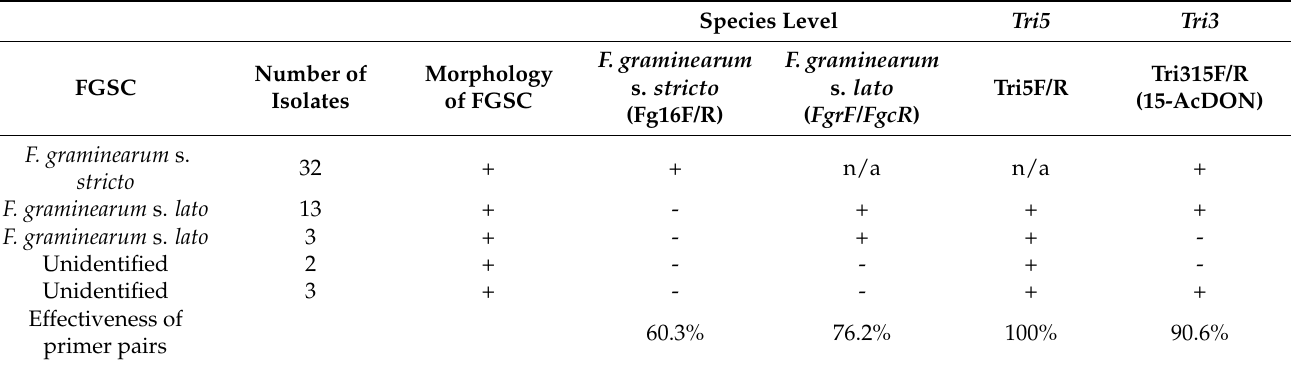
Figure 2. Factorial plots indicating effects of type of cultivation and seeding time on the FDKs of cereal crop species. Tukey’s pairwise comparisons of means were performed for 95% confidence levels. The means that do not share the same letter are significantly different. Table 3. Molecular genotypes within the F. graminearum population and the effectiveness of primer